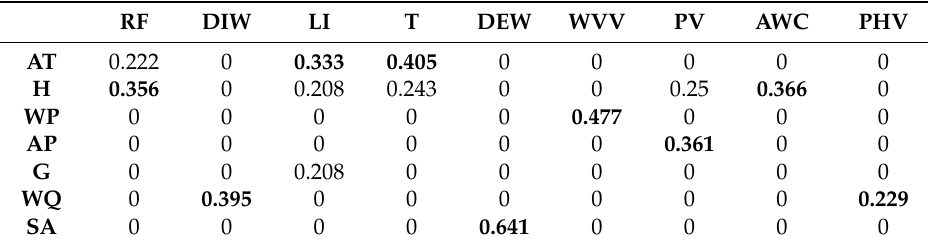
Table 8. Similarity results based on structural strategy.